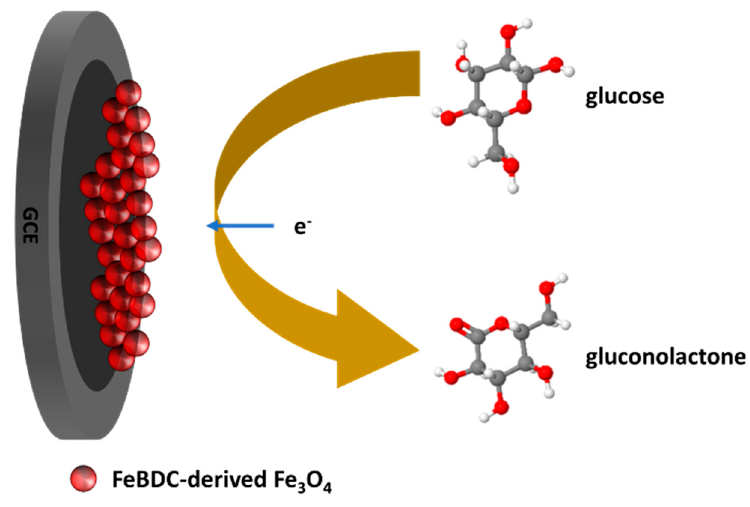
Figure 1. Schematic illustration of the glucose oxidation on the Fe 3 O 4 /GCE .